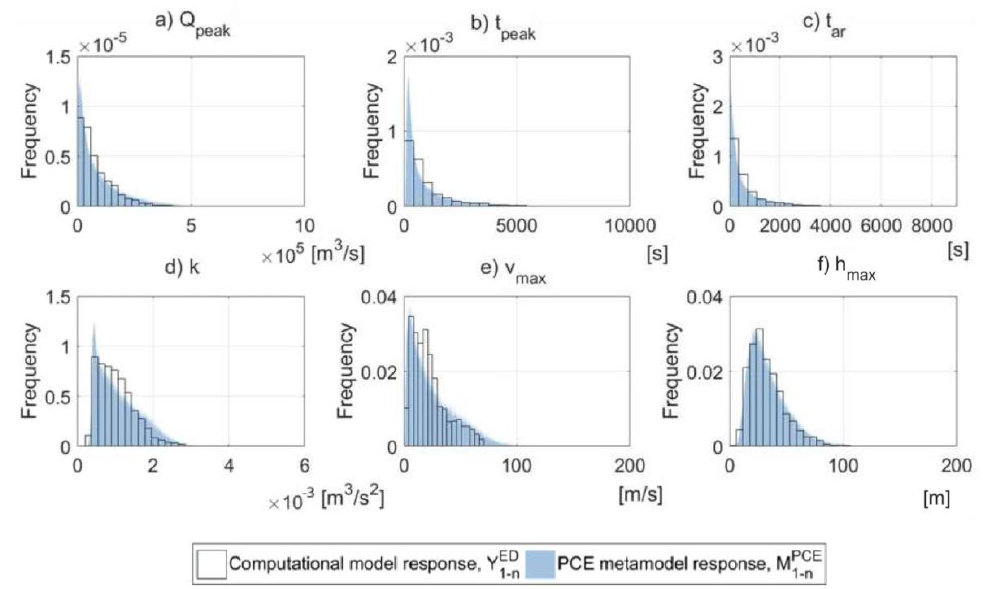
Figure 8. Model response, Y ED , and polynomial chaos expansion (PCE) response, M PCE , for ( a ) peak discharge, Q peak ; ( b ) time to the peak discharge, t peak ; ( c ) time to the flood arrival, t ar ; ( d ) recession constant, k ; ( e ) maximum water velocity, v max ; ( f ) maximum water depth, h max , at the last cross section at the end of the channel.